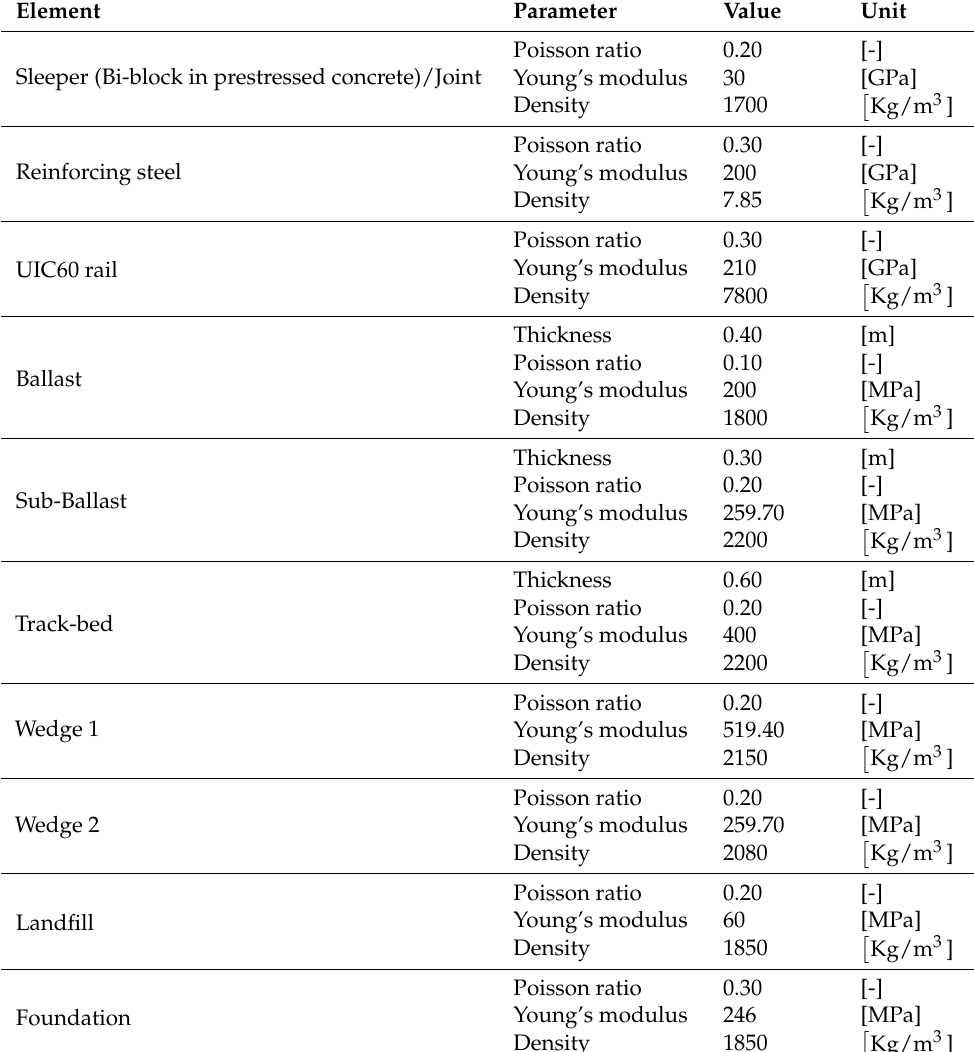
Table 1. Characterization parameters of the materials adopted in the numerical simulations. Element